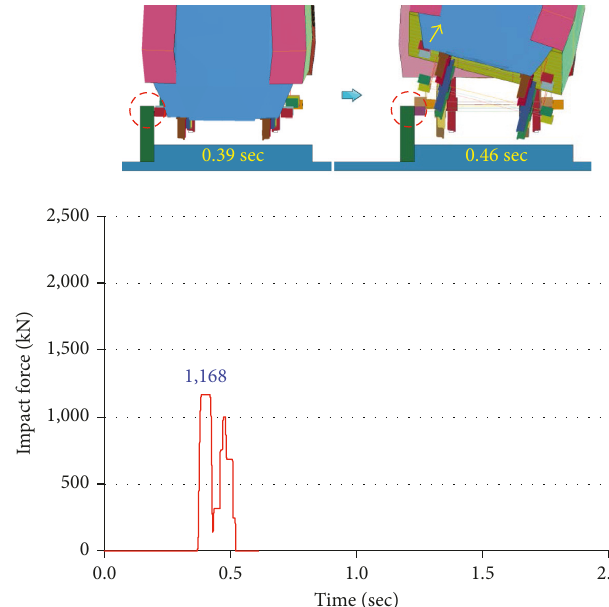
Figure 19: Derailment-collision behavior and impact force (height effect 2).